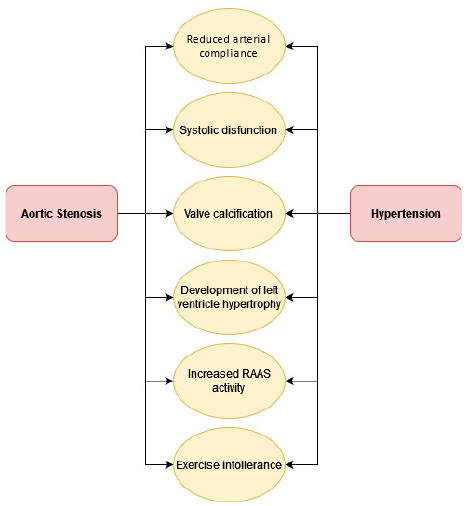
Figure 1. Connections between HT and AS.